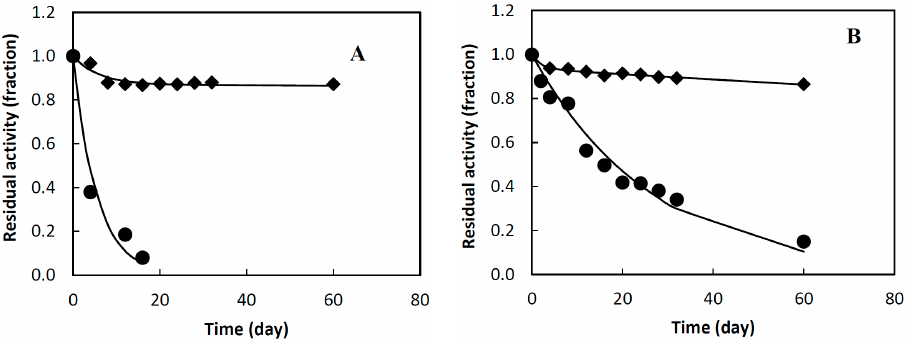
Figure 1. Stability of the catalyst in the presence of Muscat wine at 16 °C. ( A ) soluble ( ) and immobilized ( ) β G; (B) soluble ( ) and immobilized ( ) ARA. Lines represent the inactivation models. Values of inactivation parameters are presented in Table 1. Inactivation models were used for estimating biocatalyst half-life (t 1/2 ), defined as the time at which residual enzyme activity is half of its initial value, and stabilization factor (SF), defined as the t 1/2 ratio of the immobilized and soluble enzymes. Very high values of SF were obtained for both enzymes, so that t 1/2 were determined by extrapolation of the experimental data according to the corresponding models of inactivation.